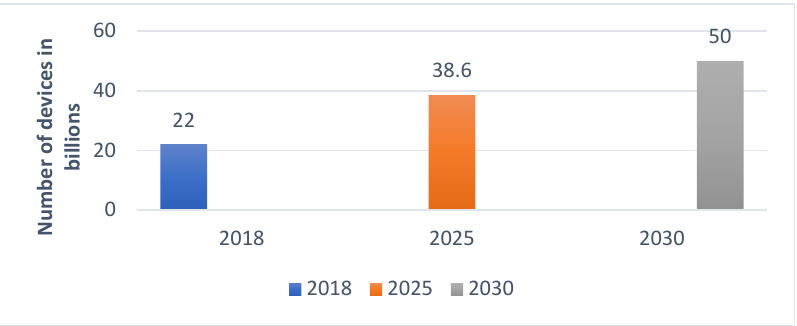
Figure 1. Number of IoT devices in billions connected globally from the year 2018 to 2030 [6].